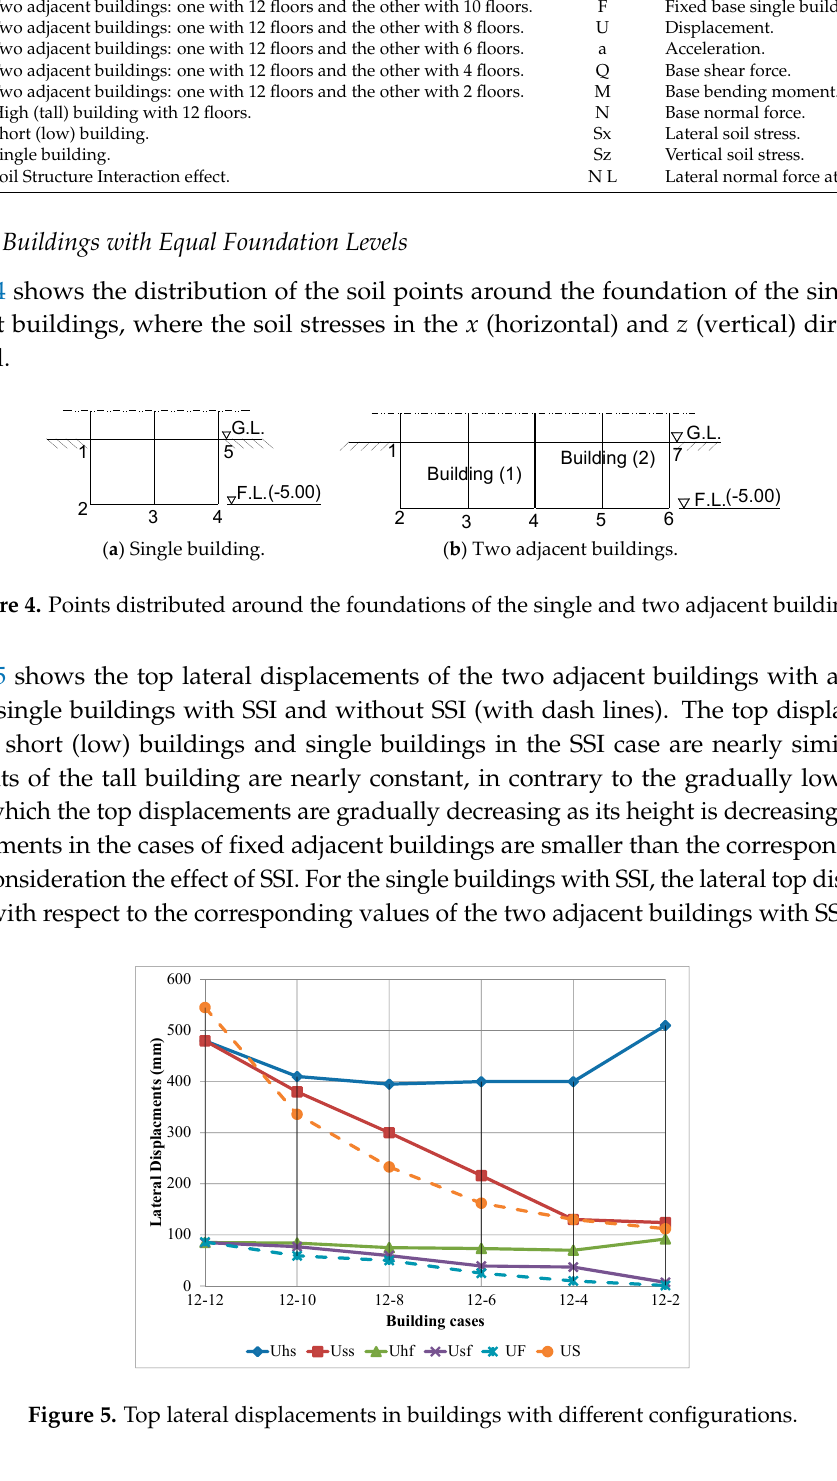
Table 2. Symbol definitions.